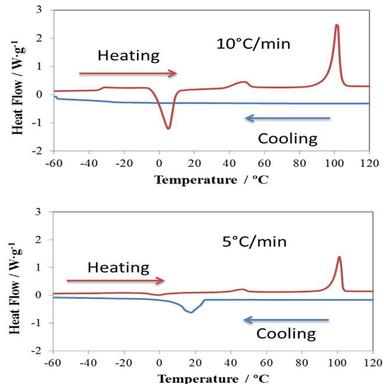
DSC curves (exo down) of at different heating rates.